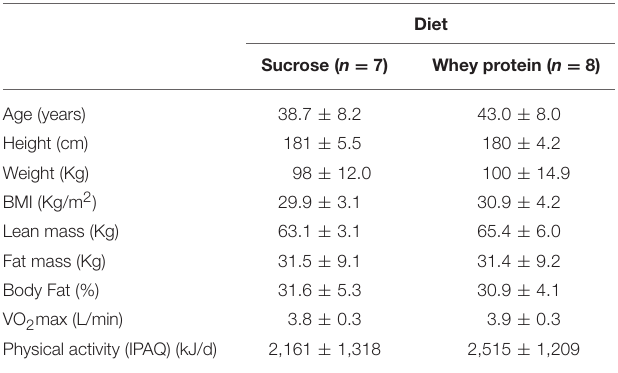
TABLE 1 | The baseline characteristics of our